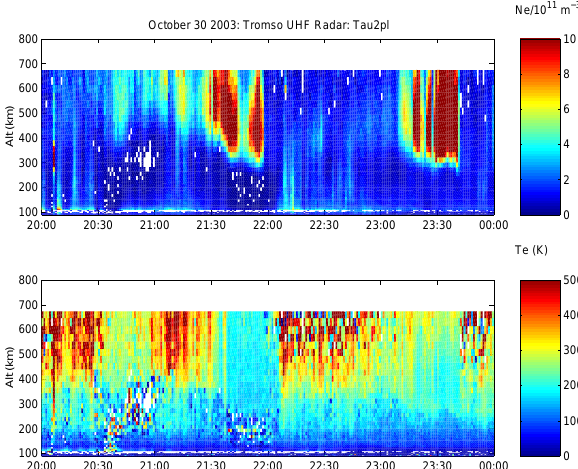
Fig. 1. Electron densities (upper panel) and electron temperatures (lower panel) measured by the EISCAT Svalbard (78 ◦ N, 16 ◦ E) radar between 20:00 and 24:00UT on 30 October 2003.